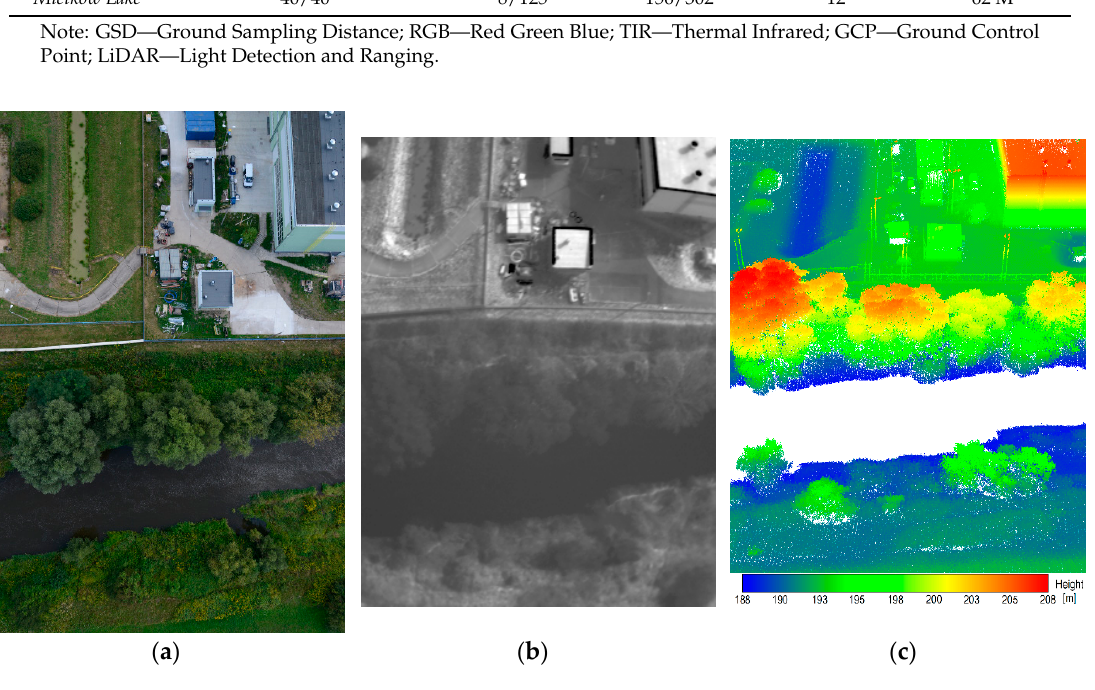
Figure 1. Examples of raw images collected with ( a ) an RGB camera and ( b ) a TIR camera and of point cloud collected with ( c ) a laser scanner. Figures are not to scale or the same projection.